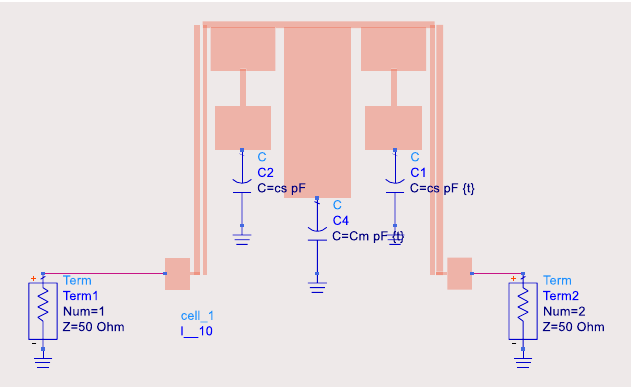
Figure 10. The proposed filter structure with PIN diodes.